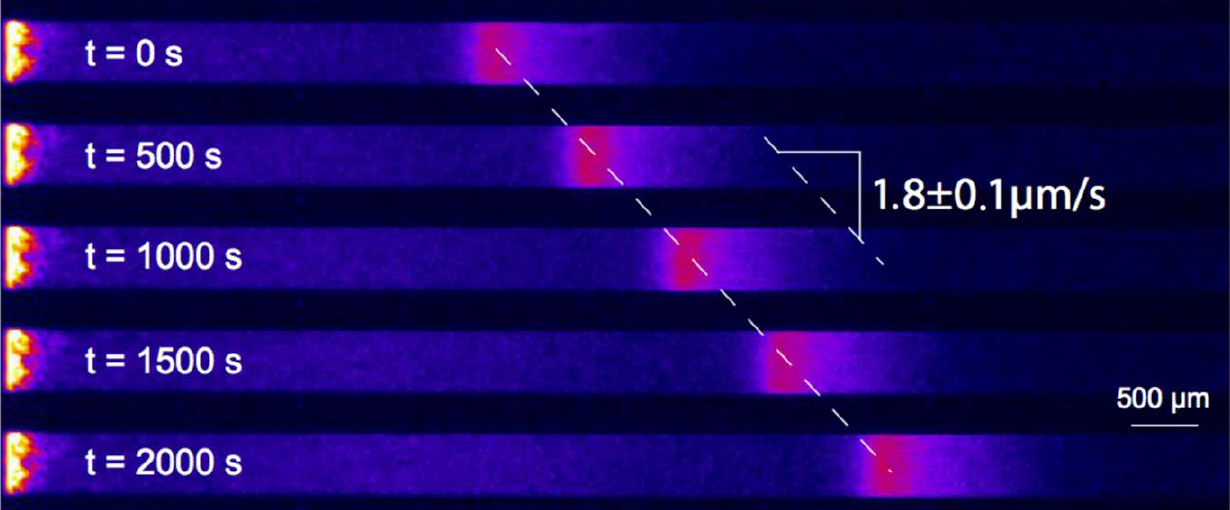
Figure 1. Experimental evidence for pulses of Escherichiacoli traveling across a channel. The propagation speed is constant and the shape of the pulse front is remarkably well conserved. Observe that the profile is clearly asymmetric, being stiffer at the back of the front (see also Fig. 2). Cell division may not play a crucial role regarding the short time scale.